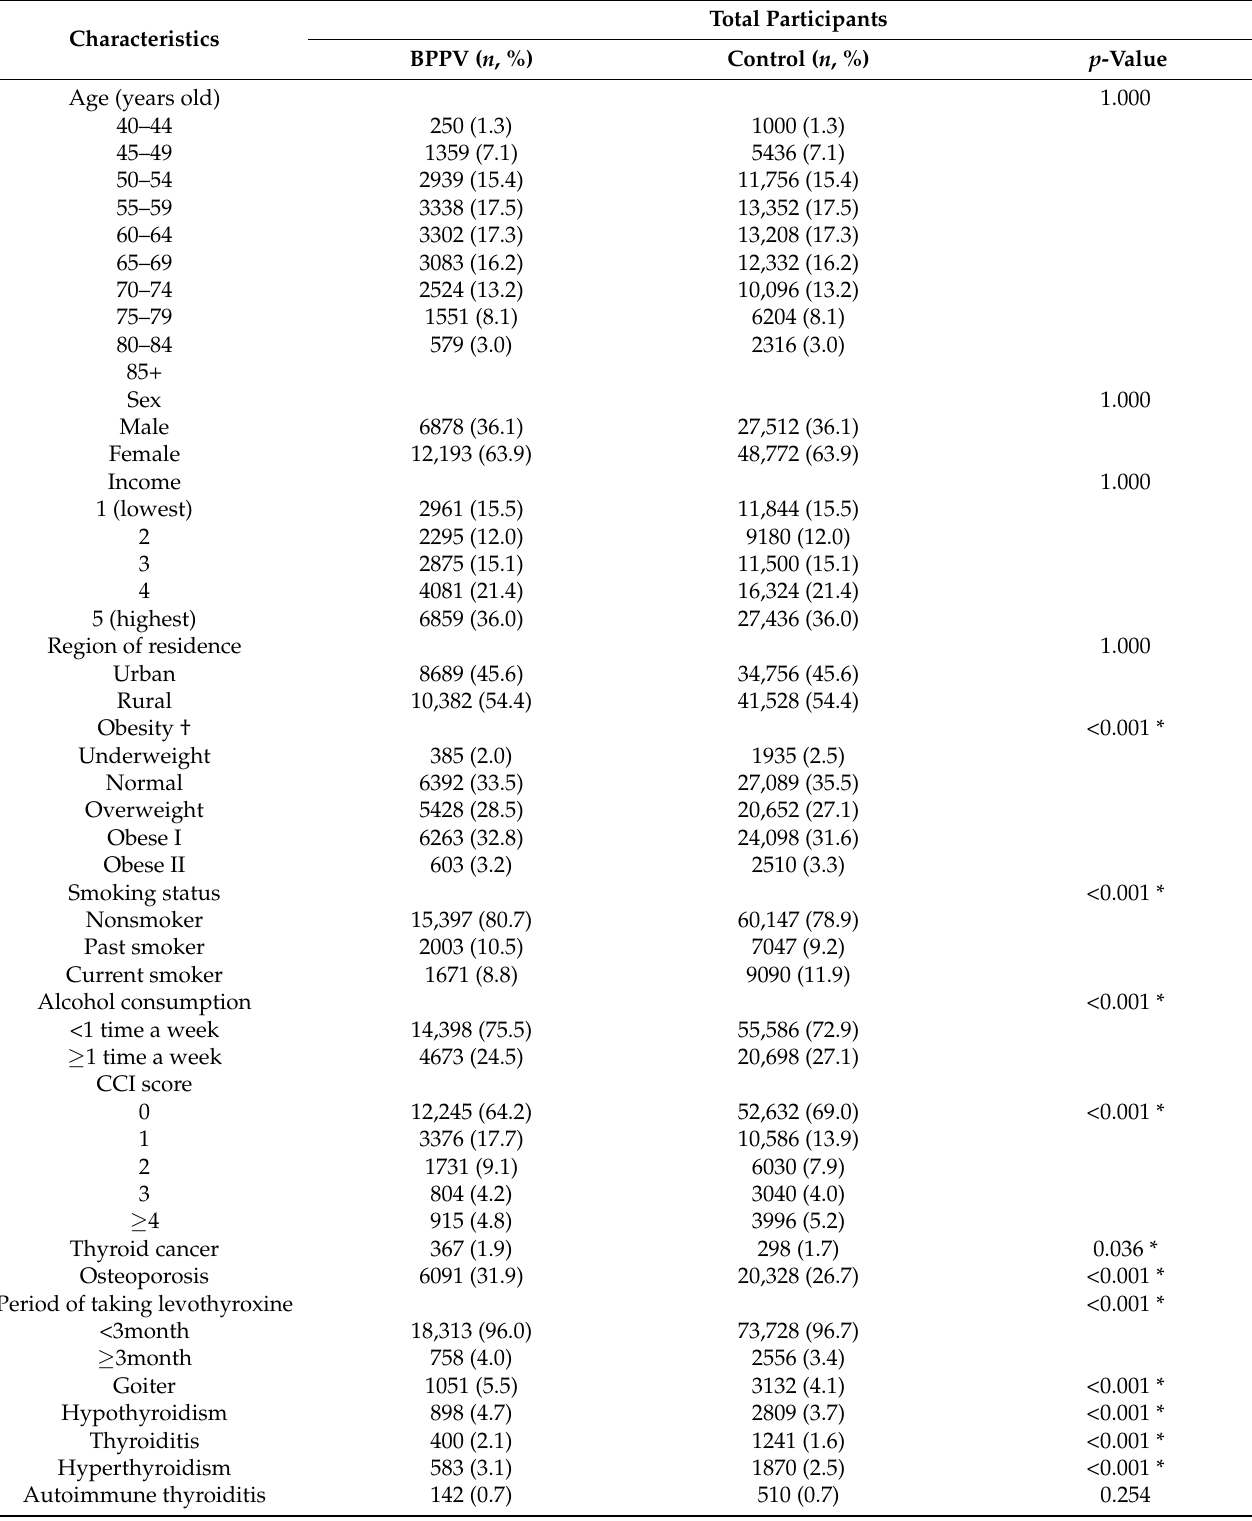
Table 1. General Characteristics of